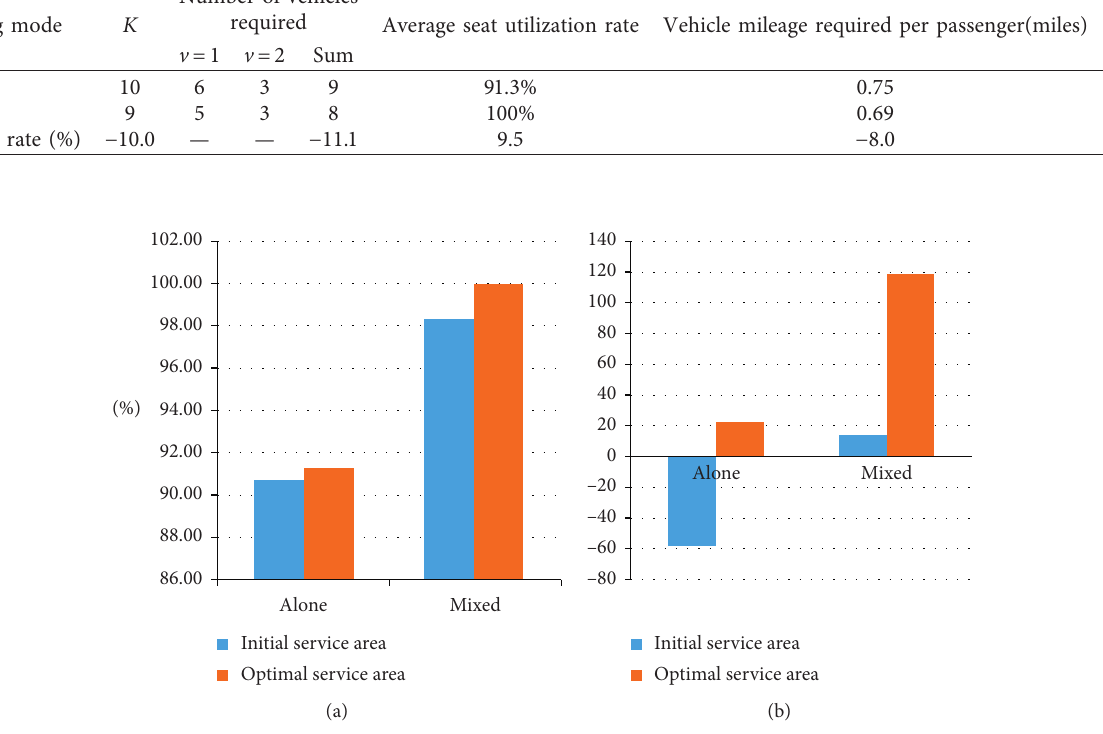
Figure 8: Comparisons of two operation modes before and after optimization. (a) Comparisons of average seat utilization. (b) Comparisons of number of vehicles